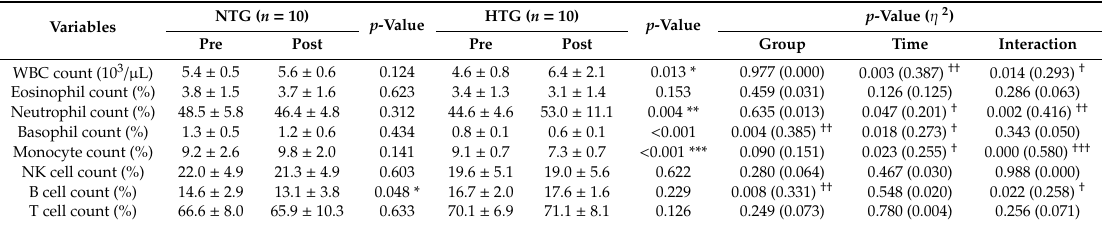
Table 5. Changes in immune function among the competitive runners before and after the tests.